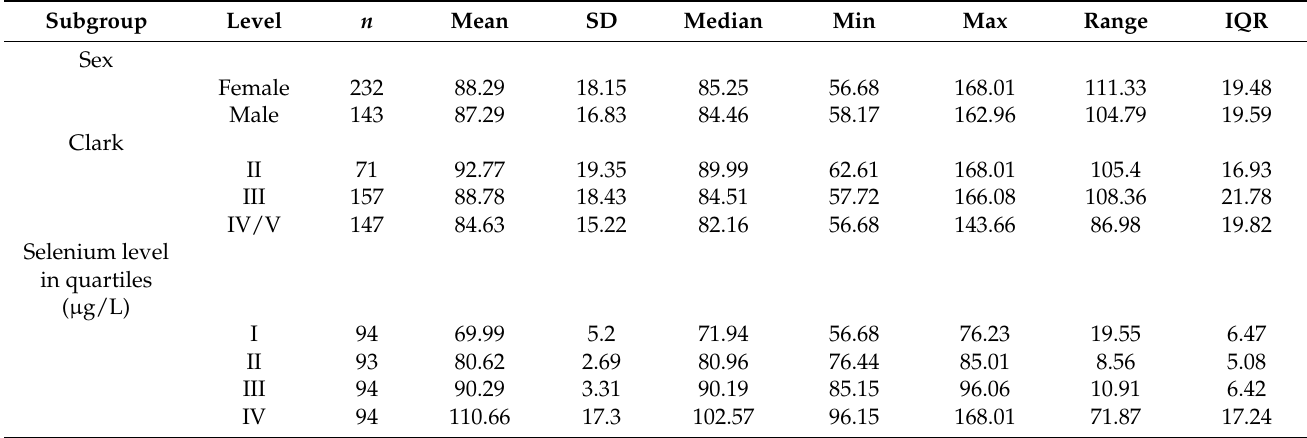
Table 2. Selenium levels by subgroups ( n =